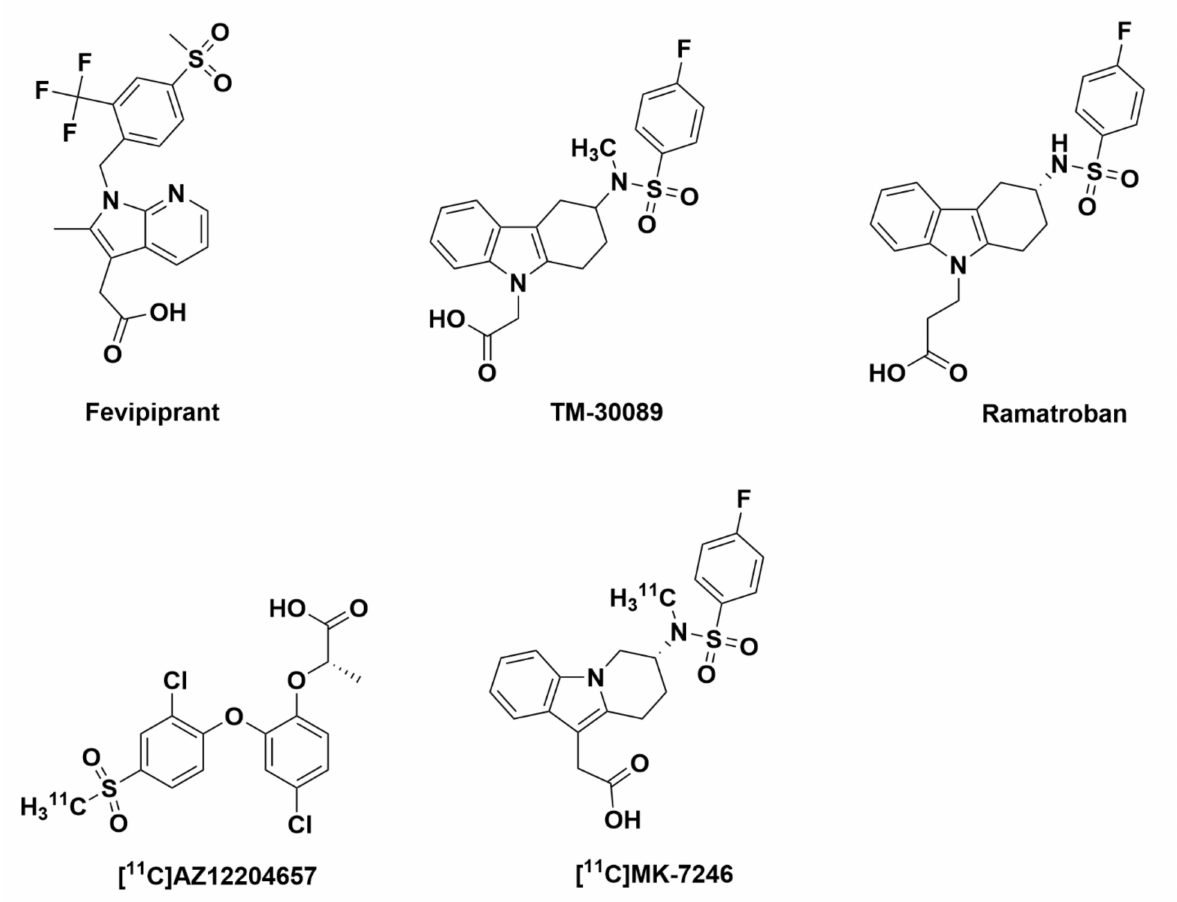
Figure 1. Molecular structures of fevipiprant, TM-30089, ramatroban, [ 11 C]AZ12204657 and [ 11 C]MK-7246